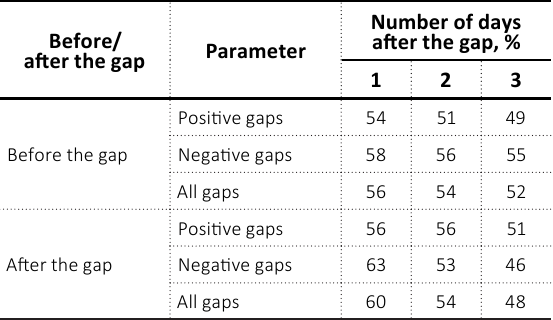
Table 2. Price patterns in the Ukrainian stock market before and after gaps